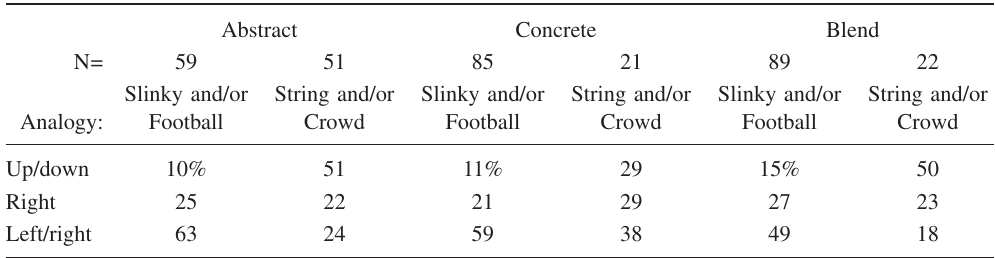
TABLE IV. Student answers to question 3 from the sound quiz, split by treatment and analogies selected.